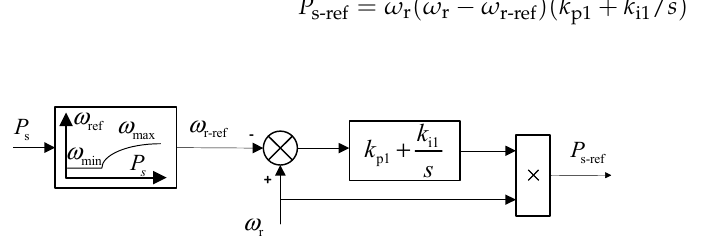
Figure 4. Control diagram of DFIG rotor speed control.